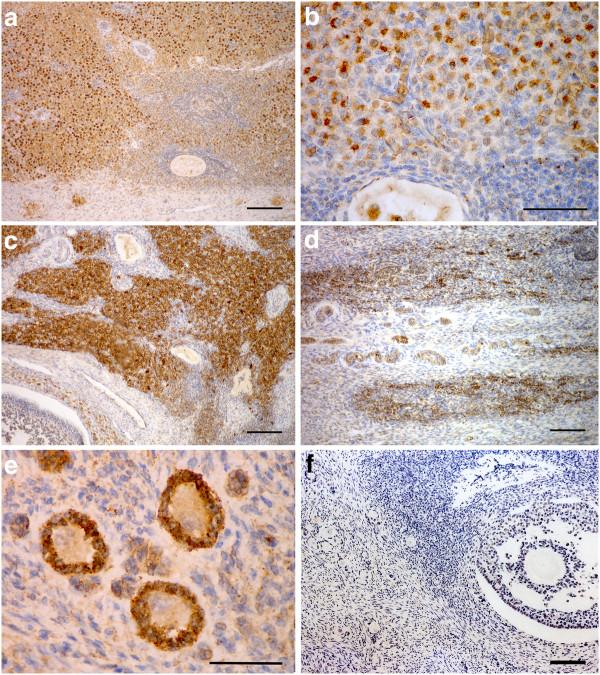
 Sections of the ovaries of elephant fetuses and calves stained immunocytochemically with an anti-3β–HSD antibody.a) Interstitial cells in a fetal ovary at 17.5 months of gestation (Scale bar = 350 μm). b) Higher magnification of the interstitial tissue showing the intense, granular staining for 3β–HSD activity (Scale bar = 40 μm. c) Positively stained interstitial tissue in the ovary of a 2 month old calf (Scale bar = 350 μm). d) 3β–HSD staining of groups of interstitial cells in the ovary of a 2.5 year old calf (Scale bar = 350 μm). e) The granulosa cells of small follicles within the cortex (and medulla in the fetal ovary) stained precisely and strongly for 3β–HSD activity in all the samples examined between 16 months of gestation and 5 years of age (Scale bar = 15 μm). f) Negative control showing the complete ablation of staining following replacement of the primary anti-3βHSD antibody with an unrelated mouse monoclonal antibody (Scale bar = 350 μm).